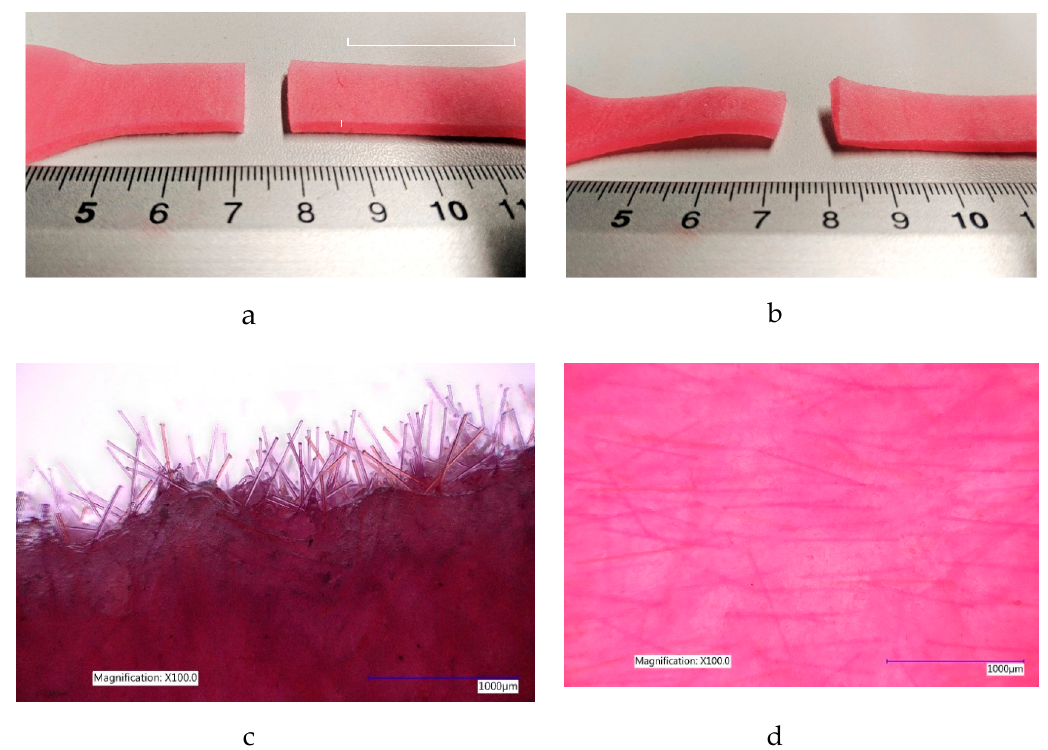
Figure 3. ( a ) Tensile test specimen has a clean break without permanent deformation at 0% and 1% fibre saturation. ( b ). Tensile test specimen begins to exhibit signs of permanent deformation at 2%, 3% and 4% fibre saturation. ( c ). The broken edge of specimen PDMS 00-30 containing 4% fibre saturation tensile test specimen at × 100 magnification after UTS evaluation. ( d ) The fibres appearing to